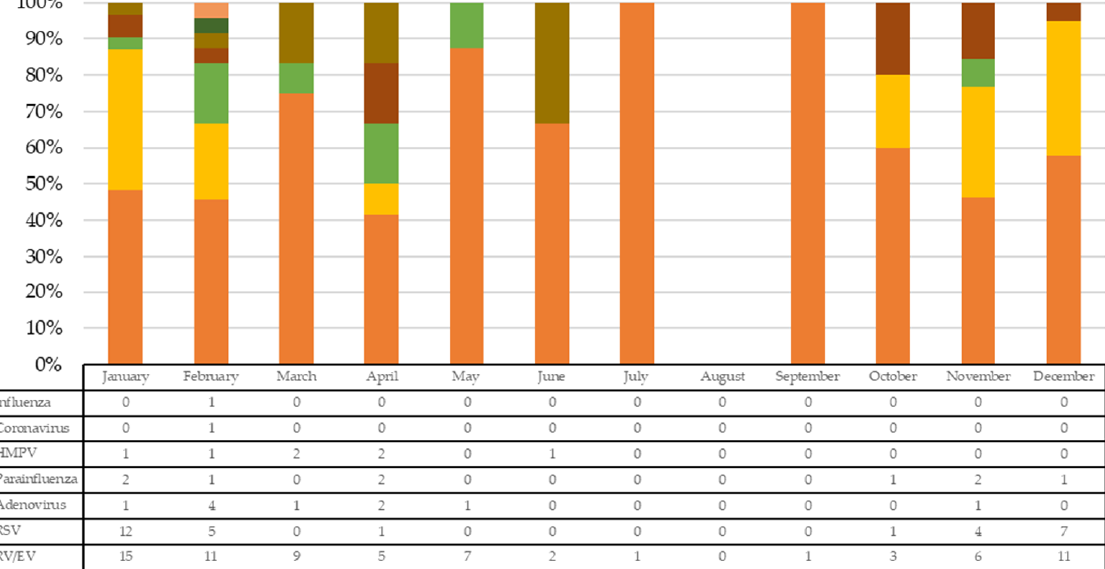
Figure 1. Number and rate of specific viral detections over the total number of detections. HMPV: human metapneumovirus; RSV: respiratory syncytial virus; RV/EV: rhinovirus/enterovirus.